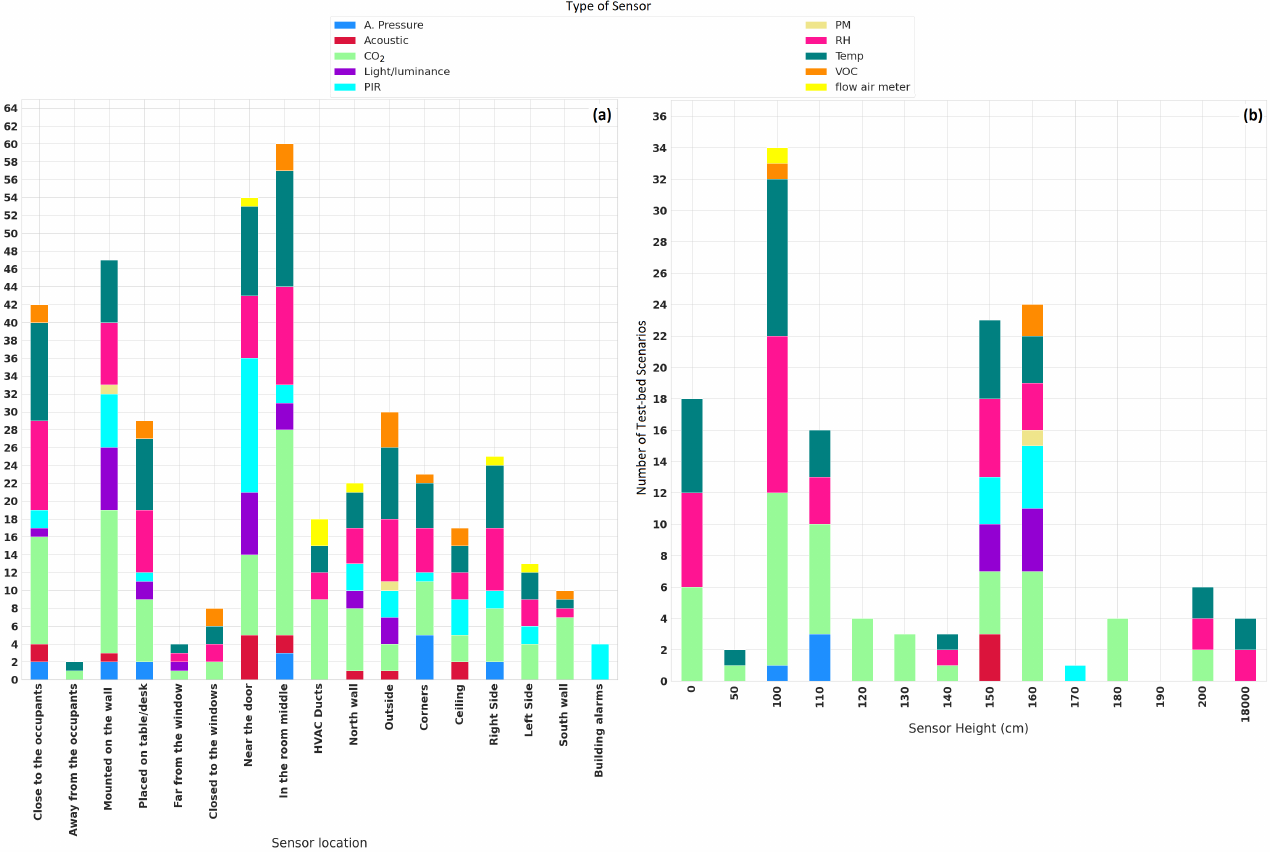
Figure 15. Specifications of the sensor deployment. ( a ) Placement of the sensors. ( b ) Installation height (cm) of the